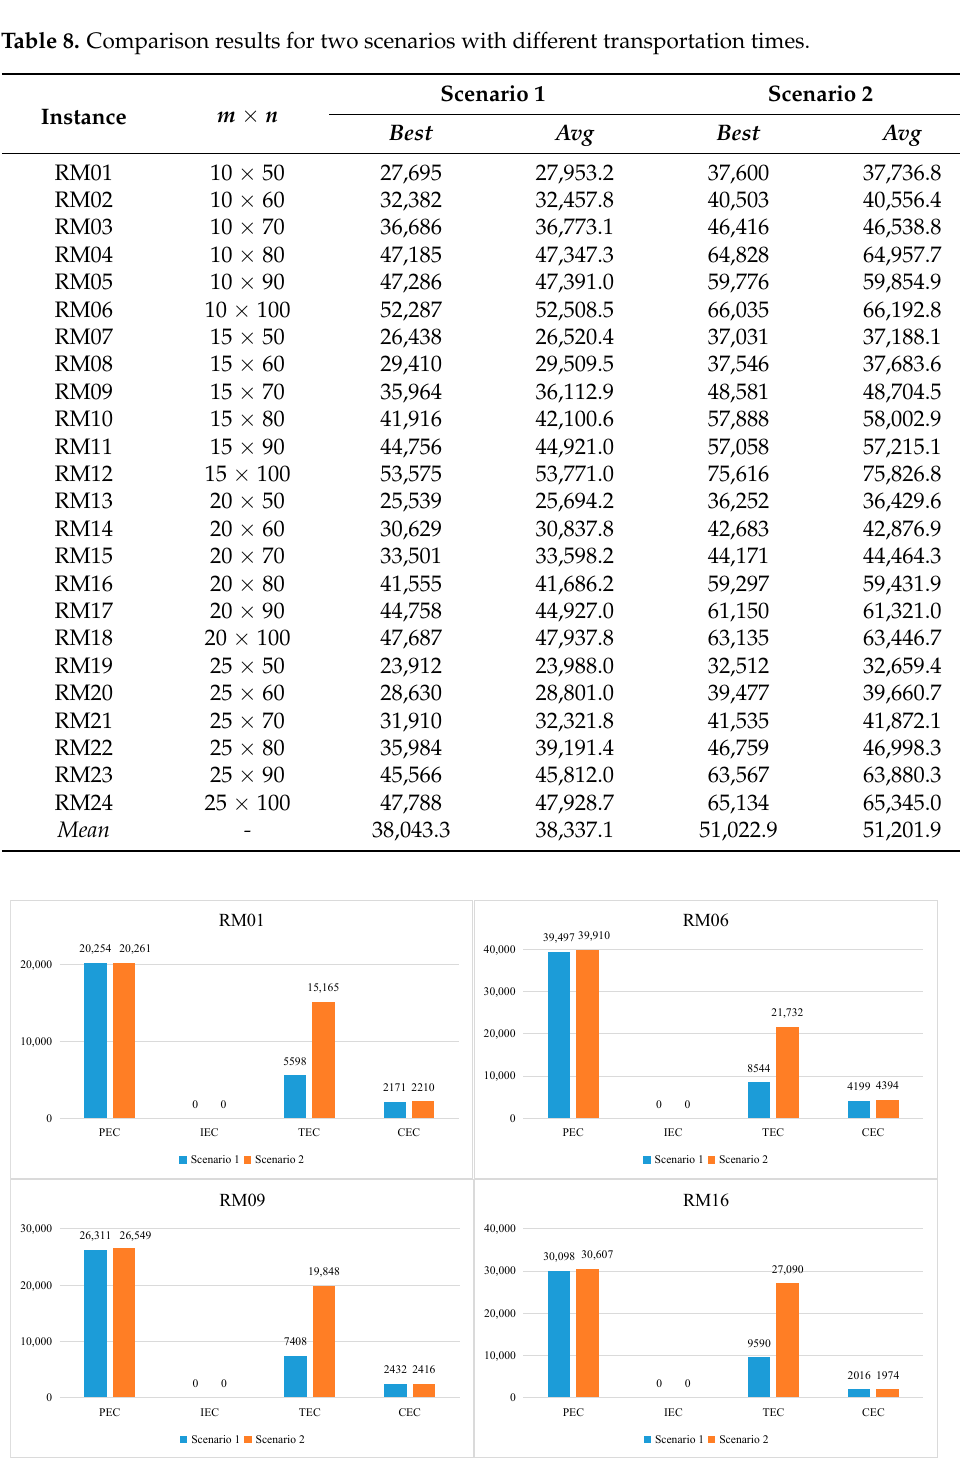
Figure 8. The histograms in the two scenarios of transportation time.